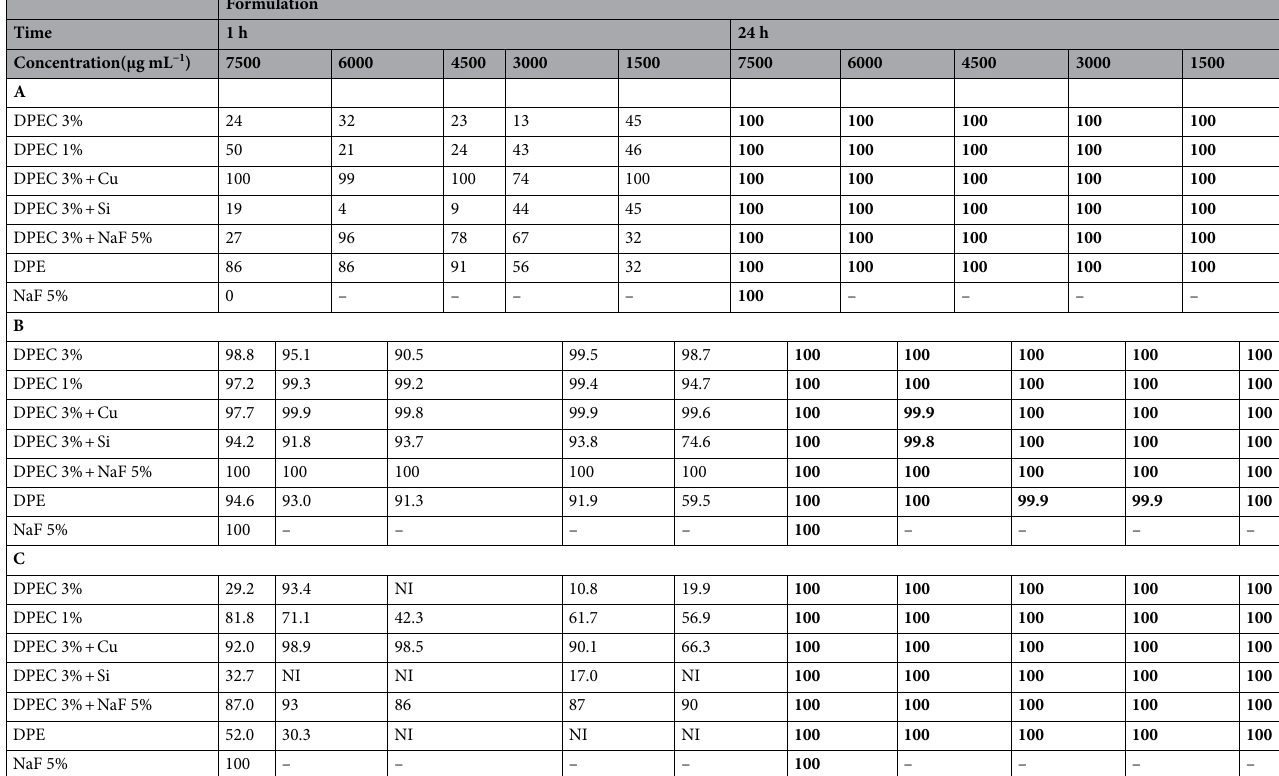
Table 3. Inhibition percentage (%) of DPEC on C. albicans (A), S. mutans (B) and L. acidophilus (C) (respectively) exposed for 1 and 24 h of direct contact with the concentration ranging from 1500 μg mL −1 to 7500 μg mL −1 of film groups.